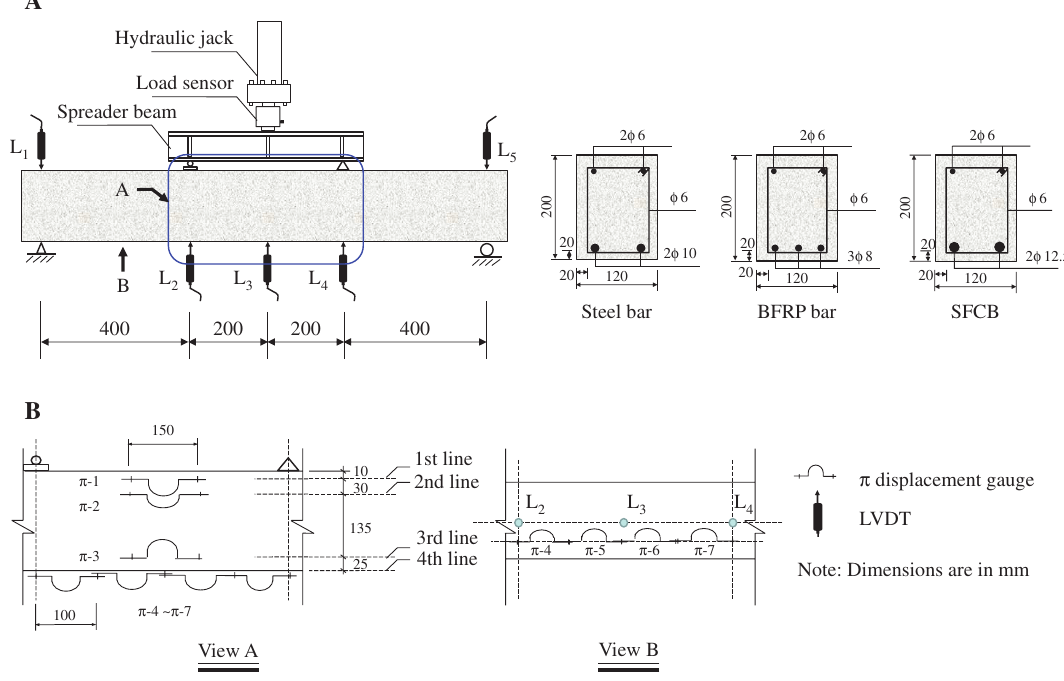
Figure 4: Beam details and test setup. (A) Loading system and beam details and (B) Arrangement of test